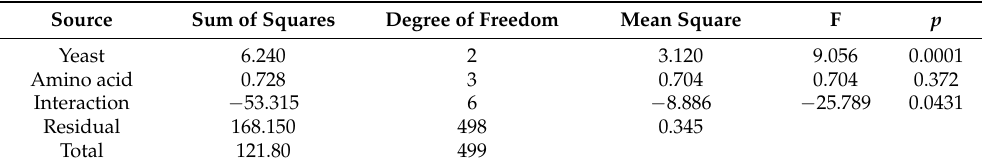
Table 2. The results of the PERMANOVA run on the data, using a certain kind of amino acids and yeast genus/species as categorical predictors. Critical p was set to 0.05.